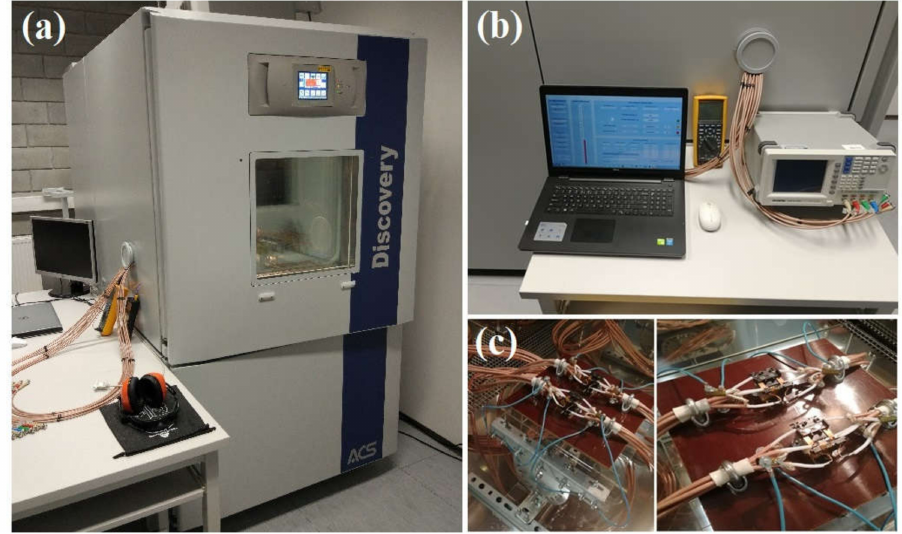
Figure 1. Laboratory stand for testing the electrical parameters of photovoltaic cells, ( a )—Discovery DY600C environmental test chamber, ( b )—measuring equipment (LCR meter, digital multimeters, computer software), ( c )—measuring holders for placing silicon samples inside the climatic